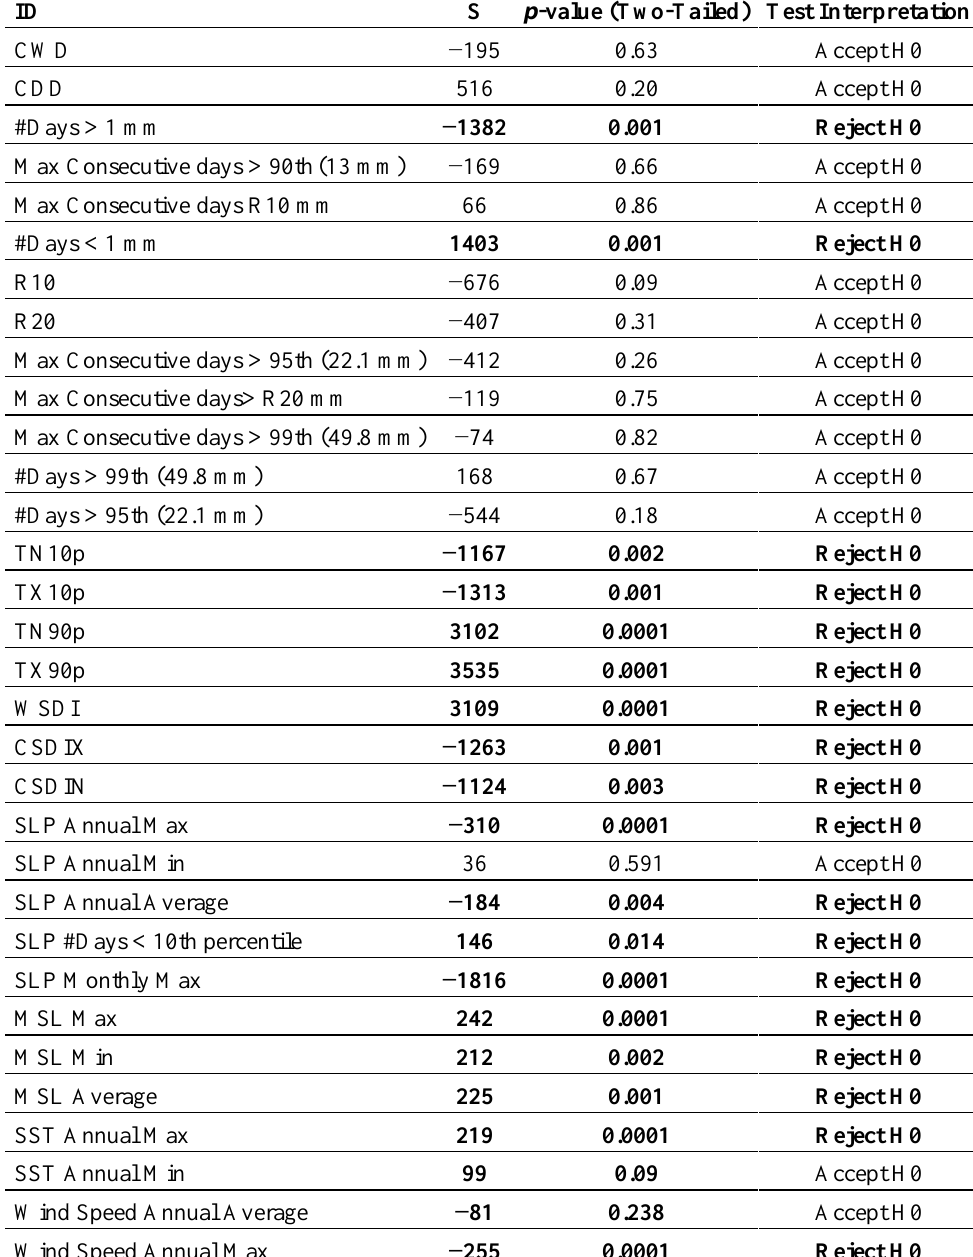
Table 3. Ocean and meteorological Mann-Kendall trend analysis. Positive ―S‖ indicates a positive trend. Negative ―S‖ values indicate negative trends. If p < 0.05, the slope is significantly different from